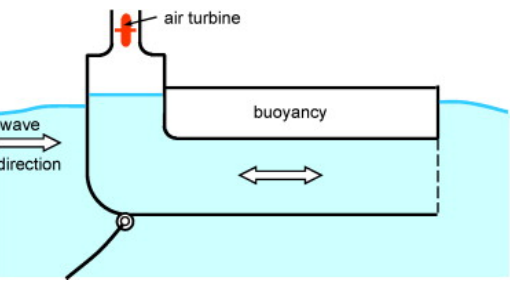
Figure 16. Section of Backward Bent-Duct Buoy (reproduced with license n. 5154830125213 from [32], Elsevier, 2010).